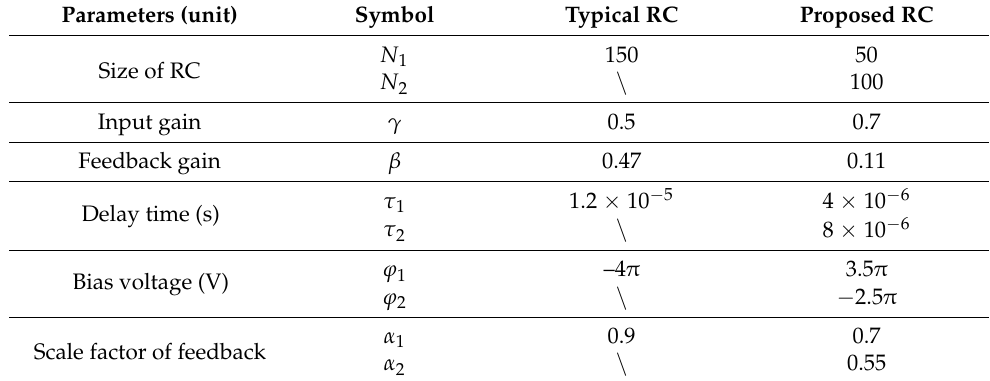
Table 2. Parameter values for the proposed RC and typical RC in our numerical simulation.